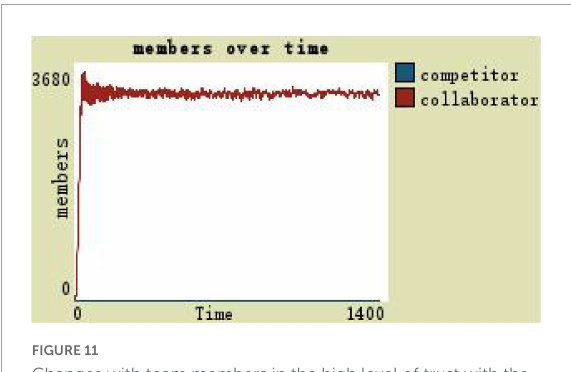
FIGURE11 Changes with team members in the high level of trust with the participatory leadership.